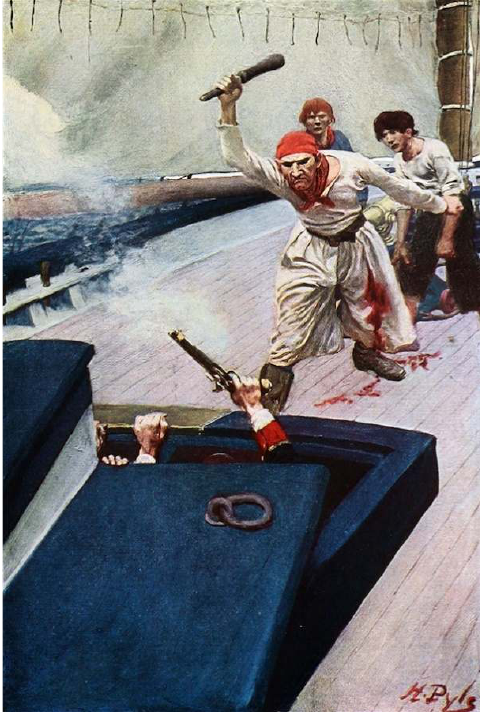
Illustration for Captain Scar fi eld